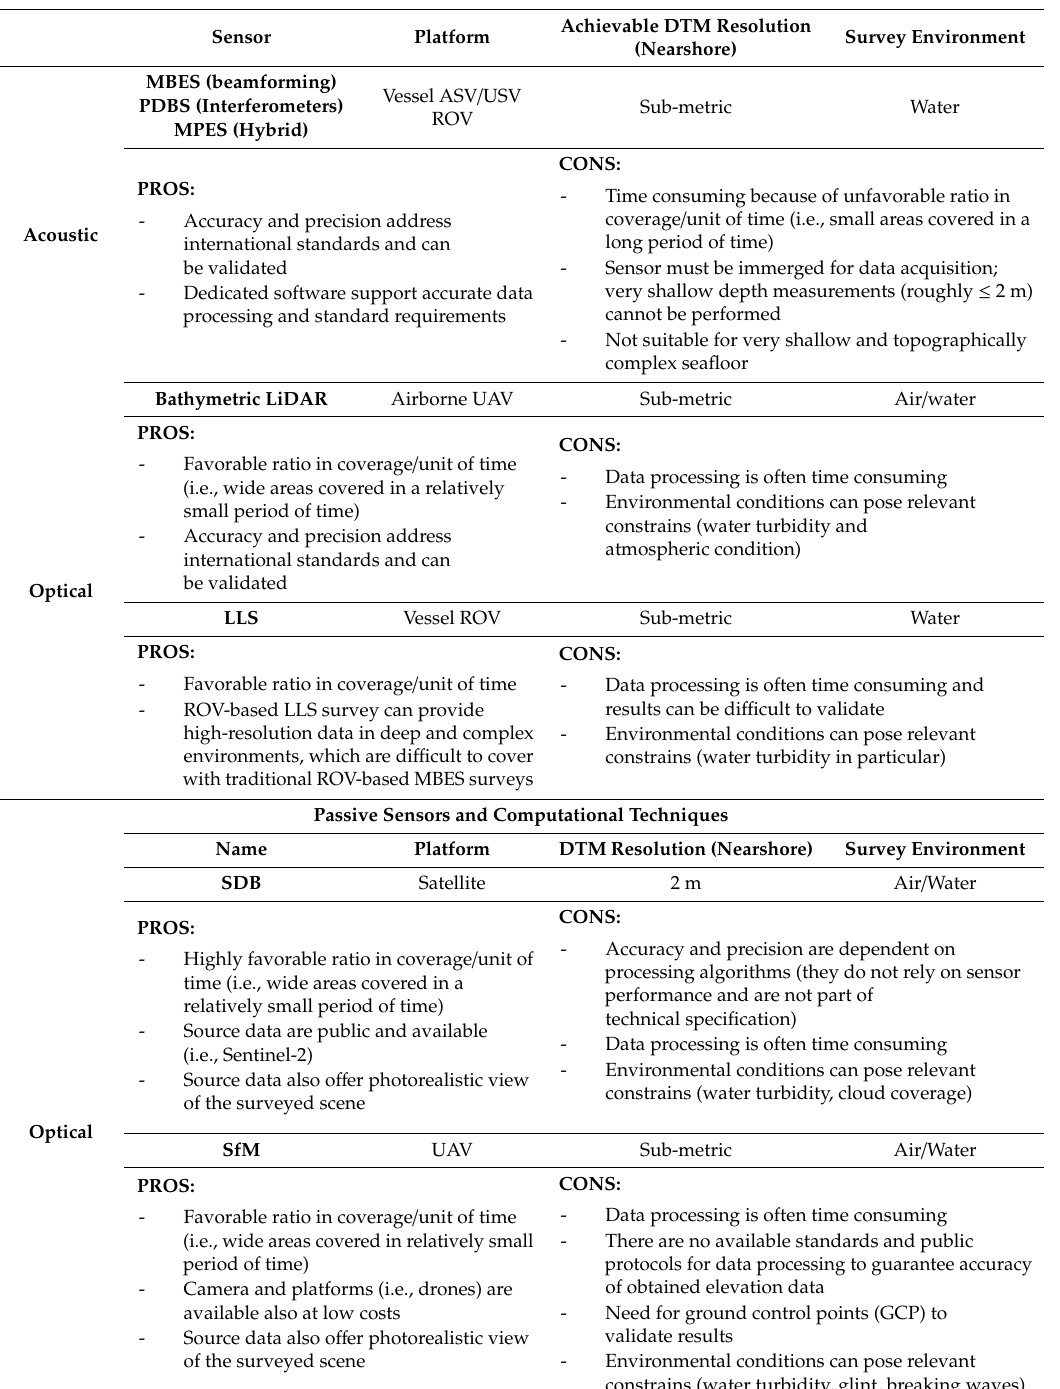
Table 2. List of sensors and techniques cited in the text which are relevant for collecting elevation data in the shallow-water environment (i.e., white ribbon). Active sensors are those sensors that control the projection of acoustic or electromagnetic waves (i.e., sound or light) onto the scene, while the term “passive” refers to those systems or techniques that use ambient light to illuminate the scene or techniques such as Structure from Motion (SfM). MBES: Multi-Beam Echo-Sounder; PDBS: Phase Di ff erencing Bathymetric Systems; MPES: multi-phase echo-sounders; ASV: Autonomous Surface Vessels; USV: Uncrewed surface vehicles; ROV: Remotely Operated Vehicle; UAV: Uncrewed Aerial Vehicle; LiDAR: Light Detecting And Ranging; LLS: Laser Line Scanning; SDB: Satellite-Derived Bathymetry; SfM: Structure from